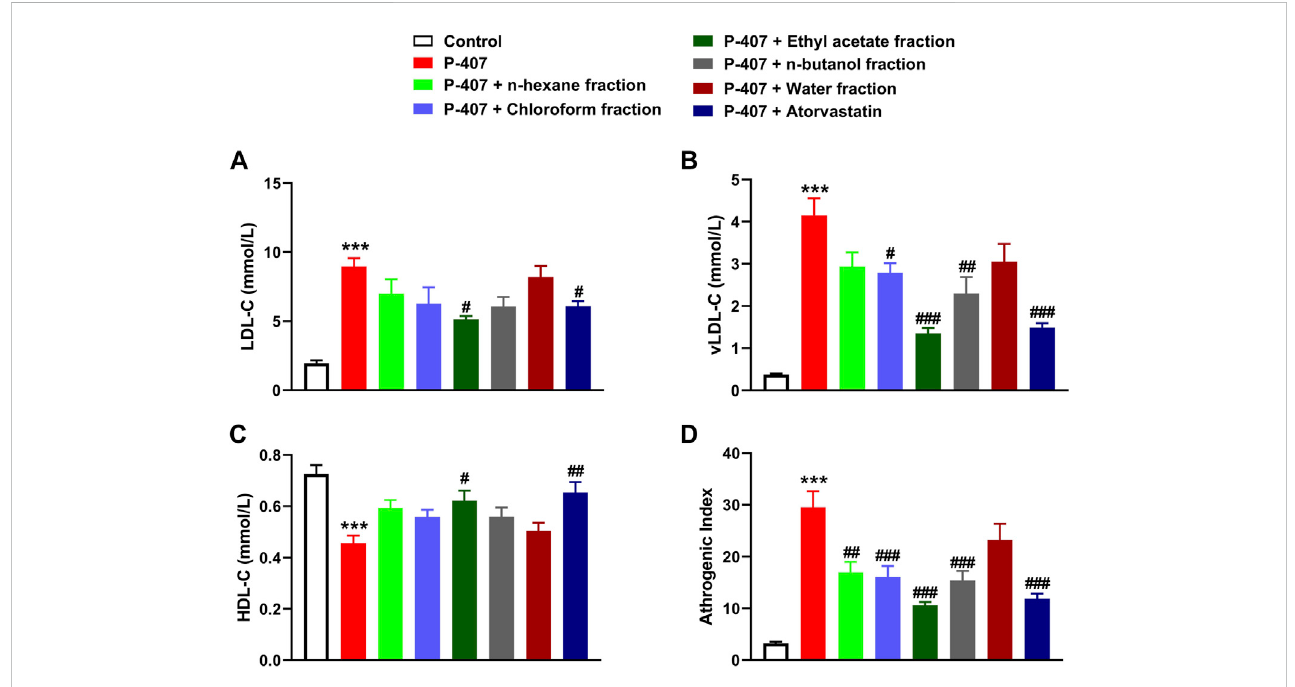
FIGURE 8 Effect of different fractions of MEACL on (A) LDL-C, (B) vLDL-C (C) HDL-C, and (D) atherogenic index after 48 h. Values are represented as mean ± SEM ( n = 6). *** p < 0.001 versus Control, and # p < 0.05, ## p < 0.01, and ### p < 0.001 versus